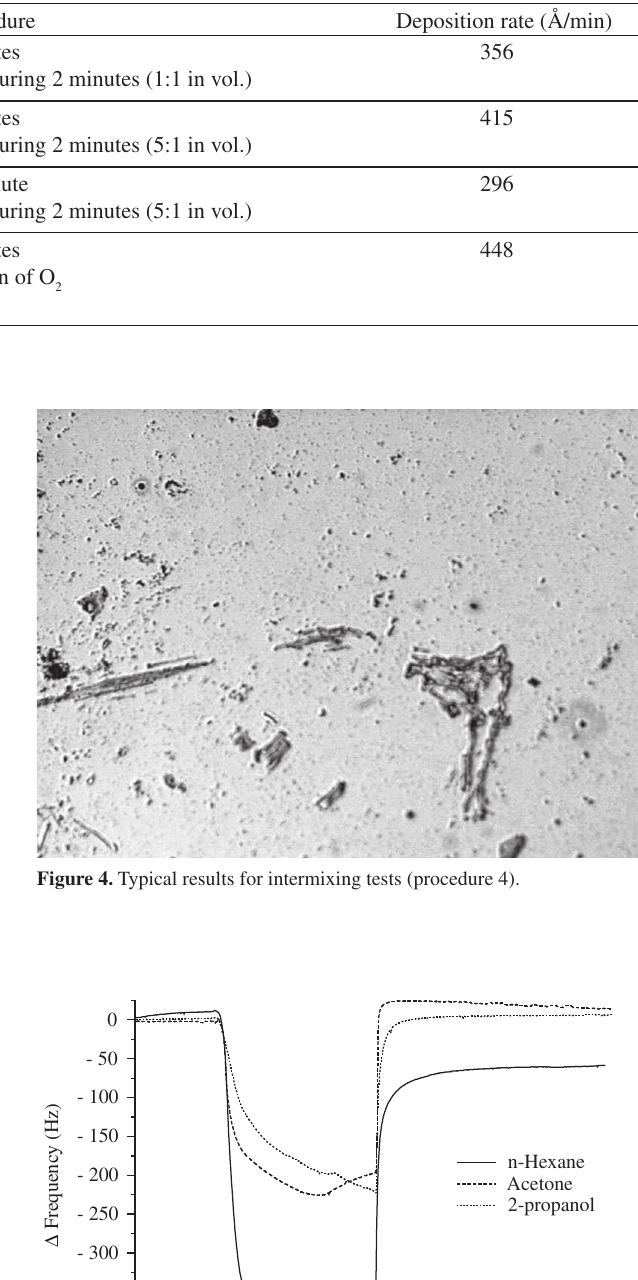
Table 1. Deposition procedures and rate for HMDS intermixing.